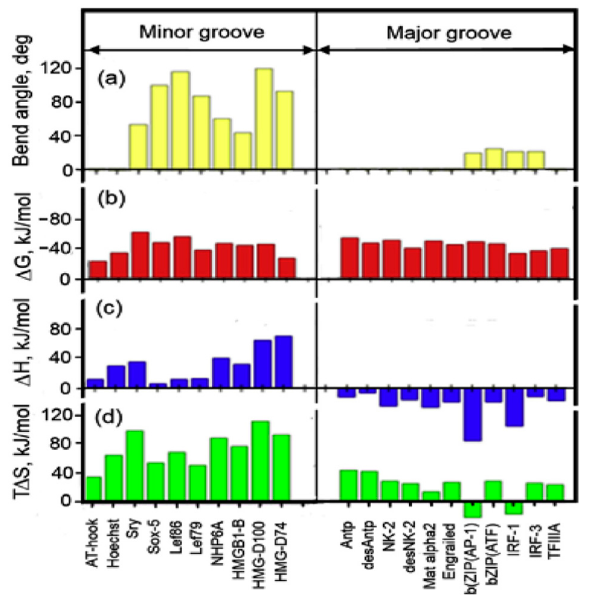
Figure 5. Binding of the DBDs of various transcription factors to their target DNA sequences: ( a ) DNA bend angles induced ( yellow ). ( b ) The Gibbs energy of binding ( red ). ( c ) The enthalpy of binding ( blue ). ( d ) The entropy factor of binding ( green ). See Ref. [10,19,20].